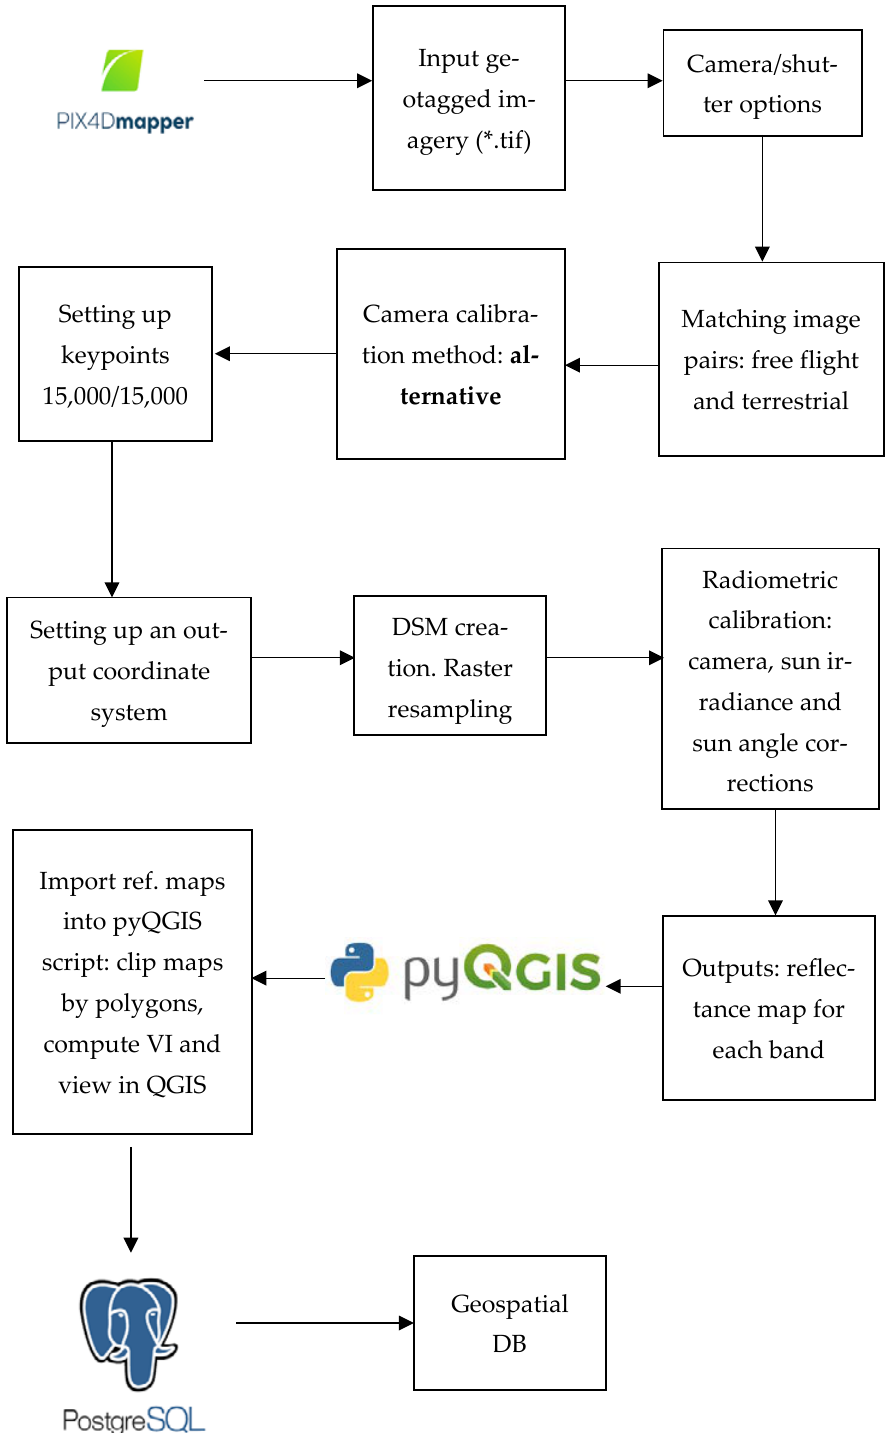
Figure 6. Finalized photogrammetric framework created by the authors. Pix4D served for photogrammetric processing only. Further computations were conducted in pyQGIS . The output rasters were added to a geospatial dataset using PostGIS .